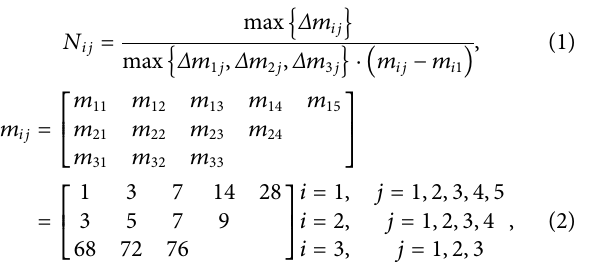
Frontiers in Materials |